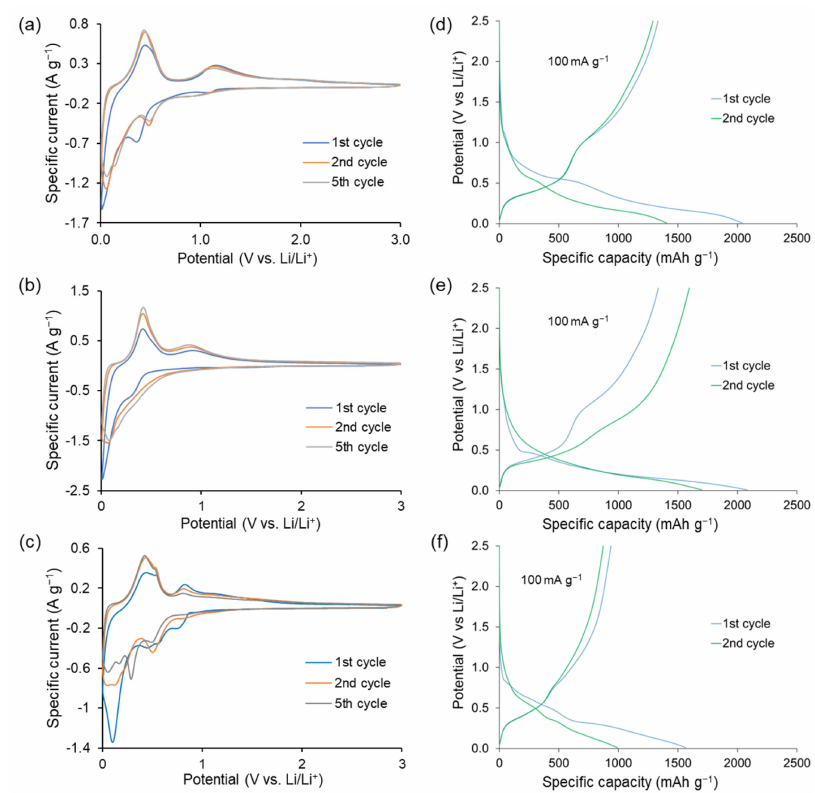
Figure 3. Cycling voltammetry of GeO 2 -rGO-80 ( a ), Ge 3 N 4 -rGO-80 ( b ), and GeP-rGO-80 ( c ) at 0.1 mV s − 1 . First and second charge − discharge curves for GeO 2 -rGO-80 ( d ), Ge 3 N 4 -rGO-80 ( e ), and GeP-rGO-80 ( f ) at 100 mA g − 1